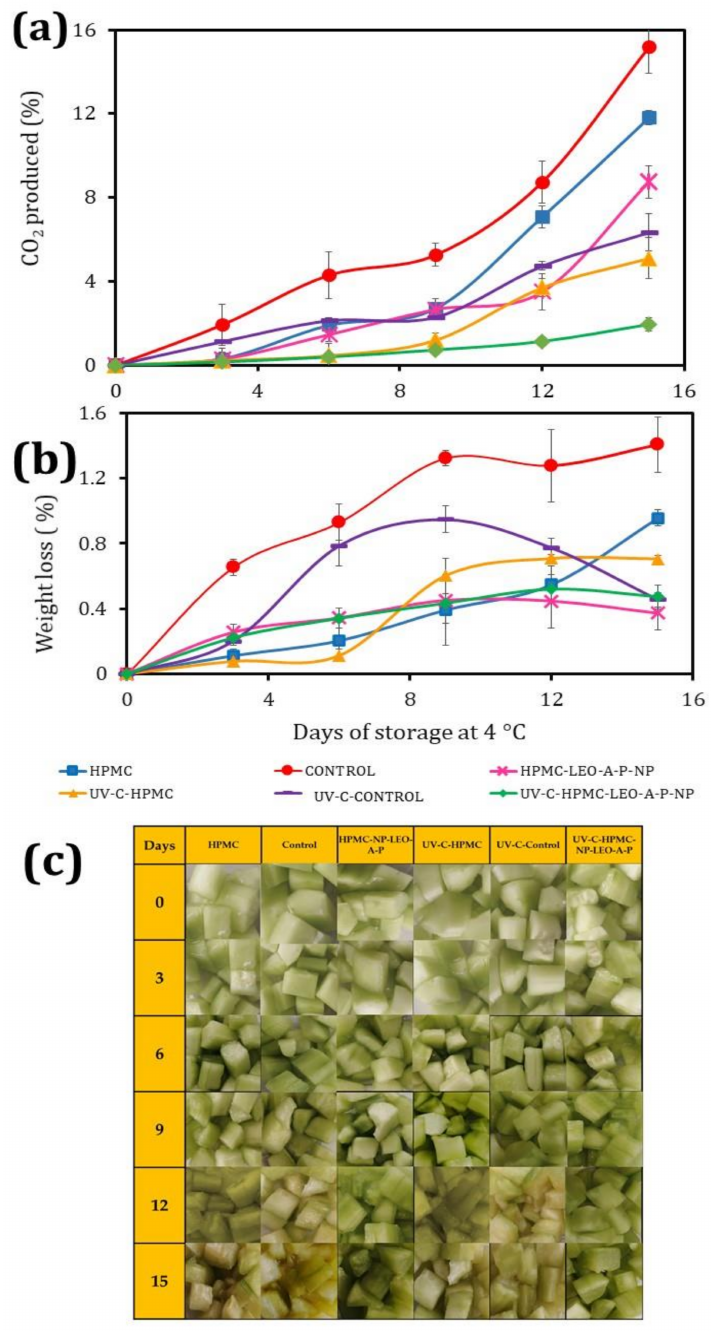
Figure 1. Changes of CO 2 , weight loss and visual evolution during storage of fresh-cut cucumber at 4 ◦ C: ( a ) CO 2 evolution on headspace, ( b ) weight loss, and ( c ) visual